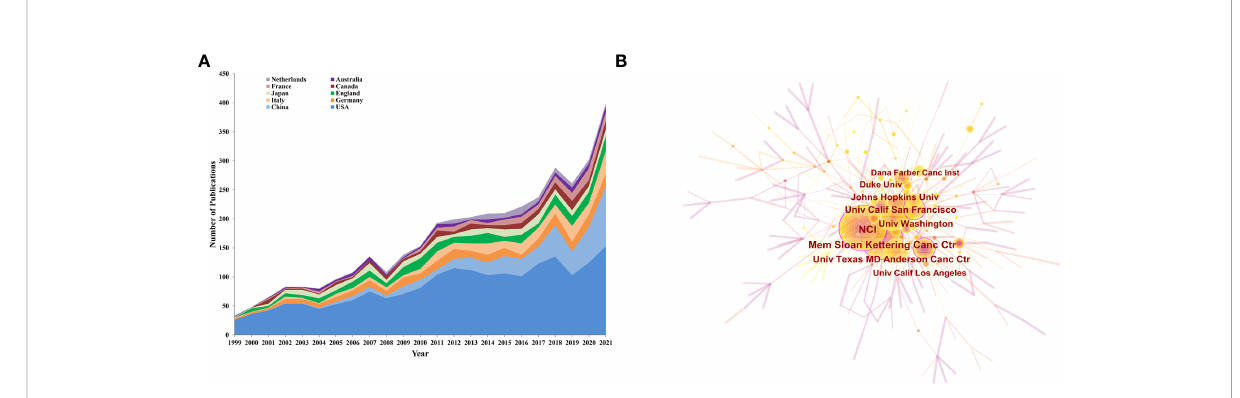
TABLE 1 Top 10 productive countries/regions and organizations related to PCa immunotherapy research. Rank Country Counts Percentage H-